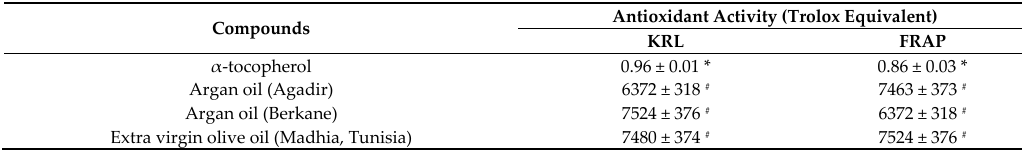
Table 5. Kit Radicaux Libres (KRL) and ferric reducing antioxidant power (FRAP) assays for estimating antioxidant